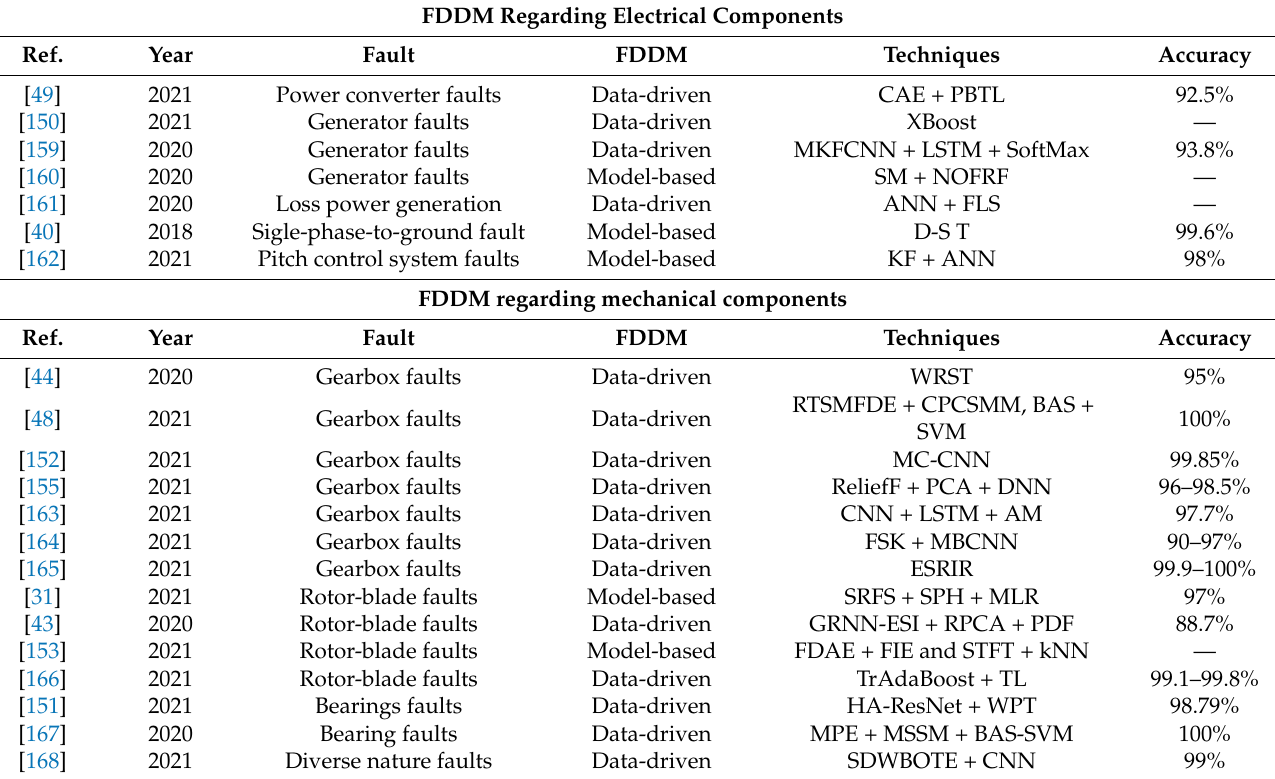
Table 4. Summary of the reported